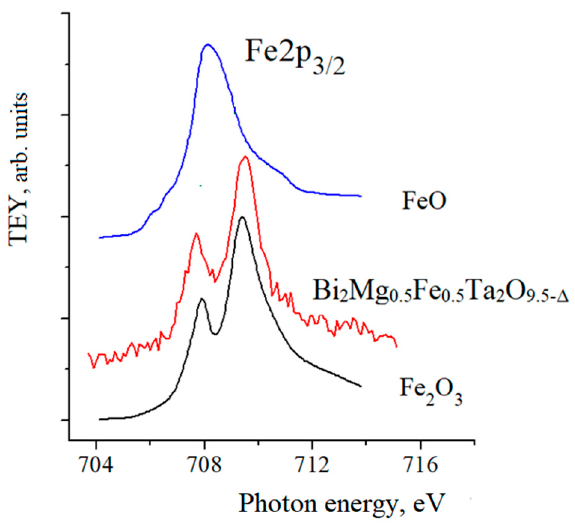
Figure 7. NEXAFS Fe2p spectra of Bi 2 Mg 0.5 Fe 0.5 Ta 2 O 9.5- Δ and iron oxides FeO and Fe 2 O 3